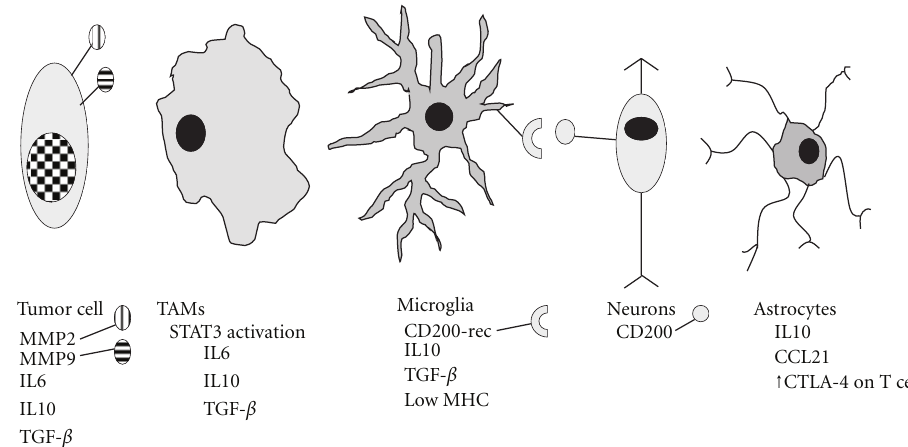
Figure 2: Tumor cells and stromal elements with immune suppressive functions. CNS tumor cells, especially glioma cells, may develop the ability to secrete cytokines including IL6, IL10, and TGF- β and can take advantage of membrane integrin-bound metaloproteases (MMP2 and MMP9) to facilitate motility and invasiveness. Tumor-associated macrophages (TAMs) bind IL6 and IL10 via their respective receptors, leading to phosphorylation and activation of STAT3, a transcription factor that upregulates TAM IL6, IL10, and TGF- β production and secretion. Ligation of the CD200 receptor on microglia by the ligand found on parenchymal neurons downregulates inflammatory cytokine and nitric oxide production by microglial cells. Microglial cells also have low expression of MHC-II and secrete IL10 and TGF- β . Astrocytes excrete IL10, and also CCL21, thus recruiting activated T cells which are then educated to upregulate CTLA-4 to antagonize costimulatory signals. IL10 promotes CNS tumor growth and migration, whereas TGF- β is an important regulator of tumorigenesis, angiogenesis, and tumor cell motility and